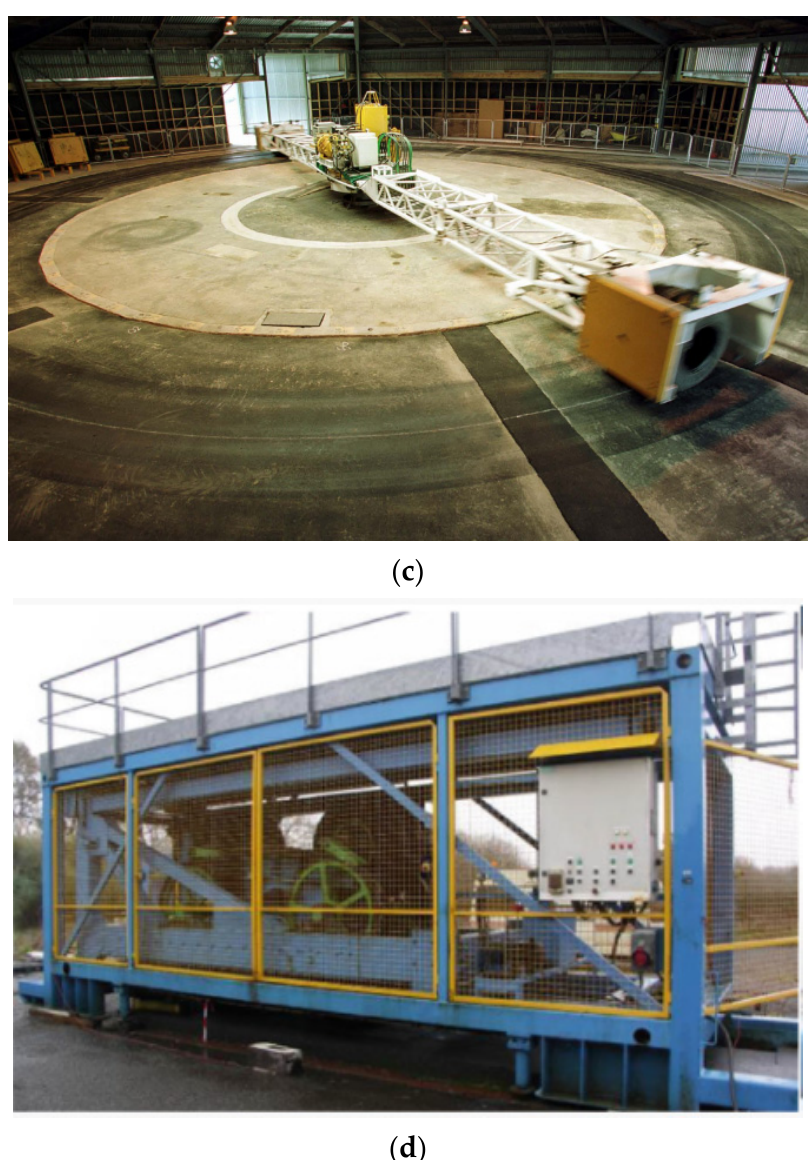
Figure 1. Pictures of different types of APTs around the world: ( a ) the Florida Department of Transportation (FDOT) HVS Mk IV device [17]; ( b ) MnROAD test road [18]; ( c ) Canterbury Accelerated Pavement Testing Indoor Facility (CAPTIF) at the New Zealand Transport Agency [19]; ( d ) the FABAC machine [20].